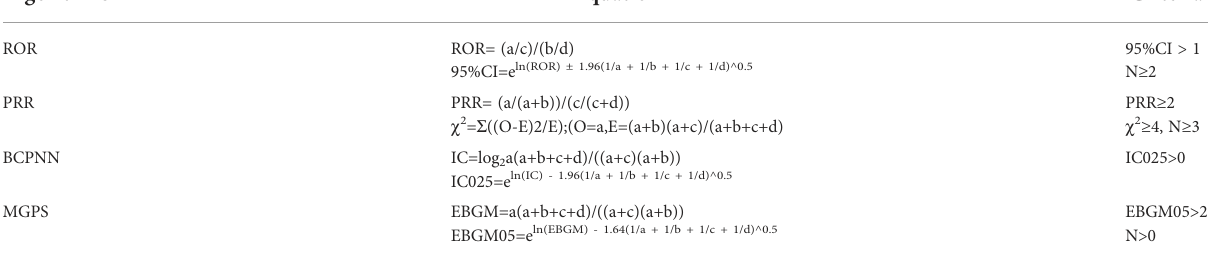
TABLE 2 Data mining methods and speci fi c formulas. Algorithms